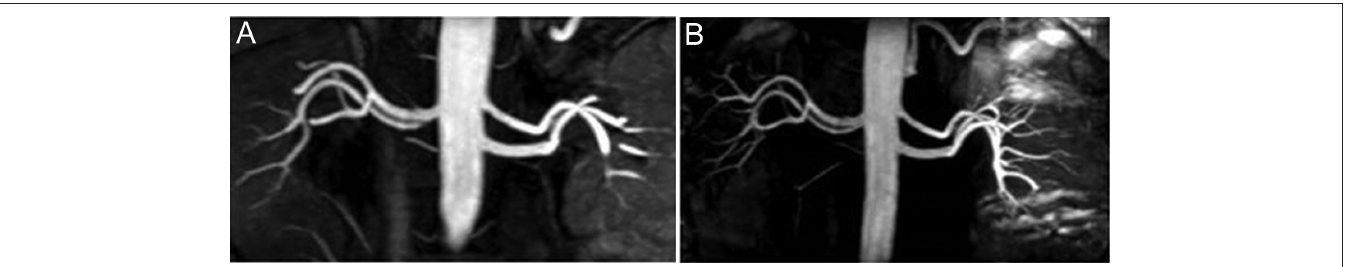
Figure 6. Coronal reformatted MIP images of Inhance sequence for a 45-year-old male patient. (A) Right early branching and (B) left accessory renal artery